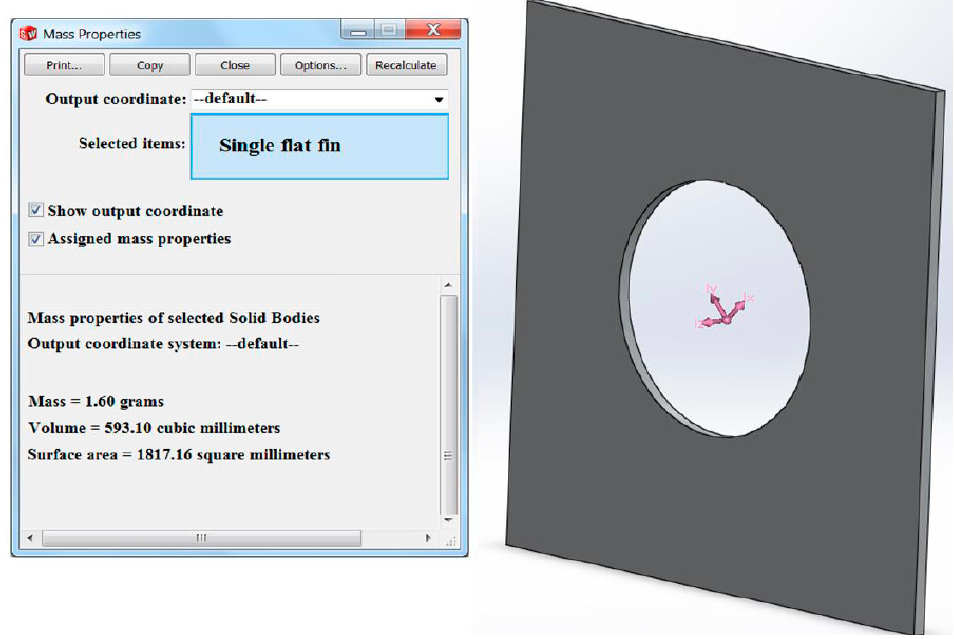
Figure 17. Single flat fin volume and surface area generated by assigning mass properties to 3D CAD model.